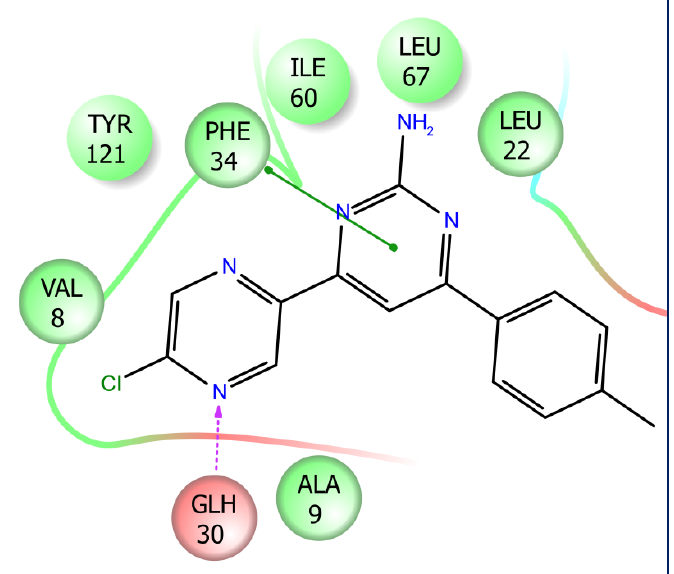
Figure 7. Receptor−ligand interaction diagram (2D view) of compound 27 at the active site of the human dihydrofolate reductase receptor. The maroon-colored arrow and green-colored lines represent hydrogen bonding and π − π interactions, respectively.